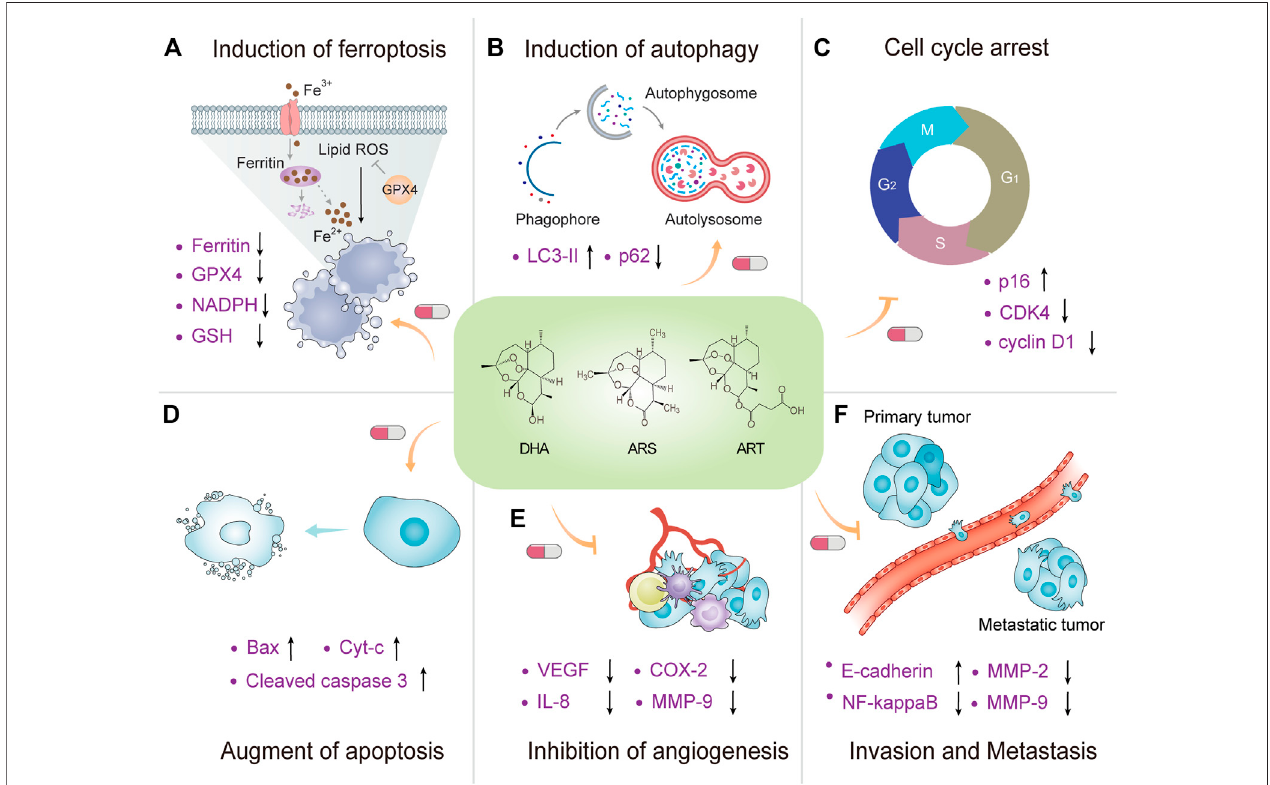
FIGURE 3 | Mechanisms of action underlying anticancer activity of artemisinins. A schematic view of the molecular crosstalk pathways involved anticancer mechanisms of artemisinins, including (A) induction of ferroptosis, (B) induction of autophagy, (C) cell cycle arrest, (D) augment of apoptosis, (E) inhibition of angiogenesis, and (F) invasion and